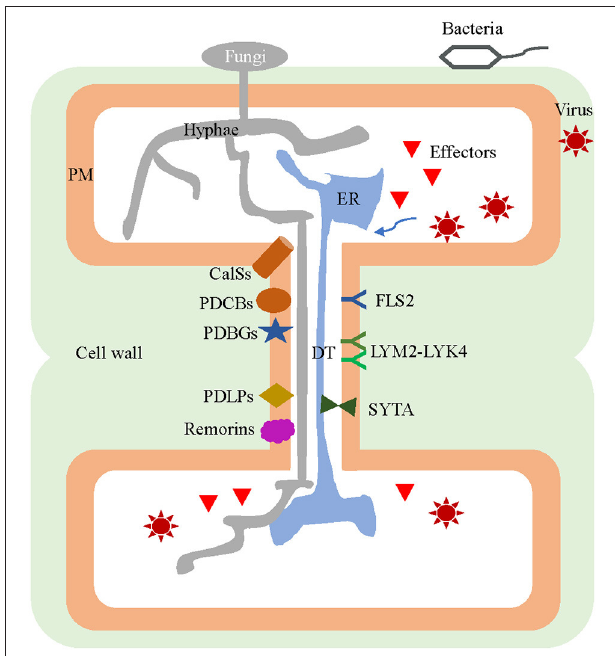
FIGURE 1 | Plasmodesmal components involved in both pathogen infection of plants and host defense responses. Virions, effectors of fungi and bacteria, as well as the fungal hyphae are transported from infected cells to the neighboring healthy cells through the plasmodesmata (PD). Many PD-localized components are jointly exploited by both pathogens and host plants, for use in their interaction during an infection. The pathogens inhibit callose synthesis by inactivating CalSs, suppressing PDCBs , destabilizing PDLPs, and/or recruiting PDBGs to assist in their intercellular movement. Viruses can interact with SYTA by relying on MP to remodel the PD. Conversely, PD harbor specific plasmodesmal PM-located receptors of LYM2-LYK4 complex and FLS2 for perception of fungal elicitor chitin and bacterial flagellin, respectively. During infection, some CalS and PDLP genes can be induced so as to promote callose accumulation and PD closure. The remorins in the membrane microdomains of plasmodesmal PM interact with MP and impede the movement of the virus among host cells. PD, plasmodesmata; DT, desmotubule; CalS, callose synthase; PDCB, PLASMODESMATA CALLOSE-BINDING PROTEIN; PDLP, PD-LOCALIZED PROTEIN; PDBG, plasmodesmal-localized β -1,3 glucanase; SYTA, synaptotagmin A; MP, movement protein; PM, plasma membrane; LYM2, LYSM-CONTAINING GPI-ANCHORED PROTEIN 2; LYK4, LysM-CONTAINING RECEPTOR-LIKE KINASE 4; FLS2, FLAGELLIN